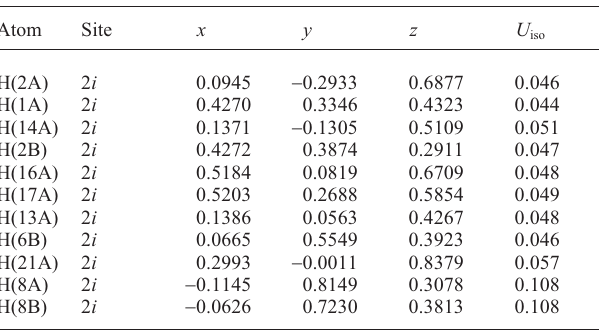
Table 3. Atomic coordinates and displacement parameters (in Å 2 ) .